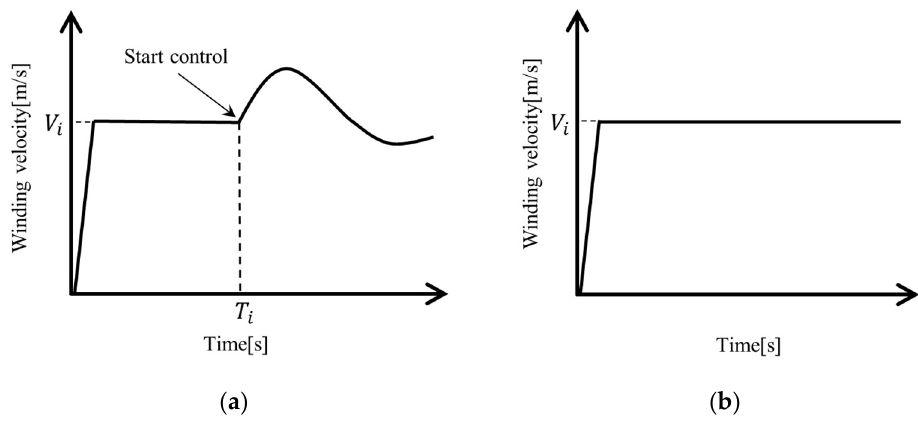
Figure 10. Outline of initial winding velocity. ( a ) With control; ( b ) Without control.